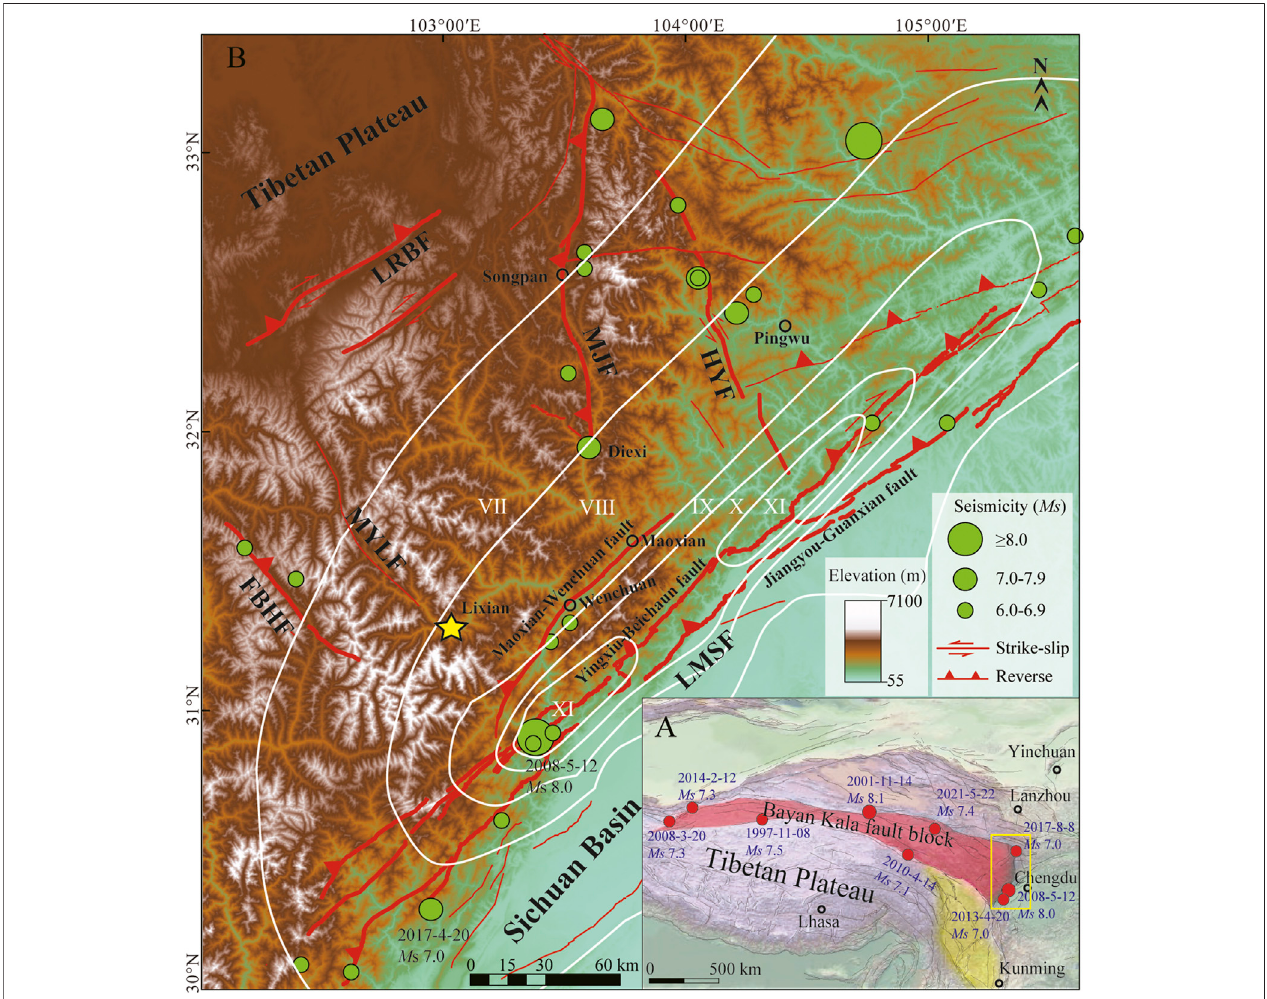
FIGURE 1 | Tectonic setting of the eastern margin of Tibetan Plateau (A) Epicenters distribution for M s ≥ 7.0 earthquakes in the Bayan Kala fault block since 1995 (Deng et al., 2014). Yellow box shows the extent of the B diagram (B) Major active faults (Xu et al., 2009) and the seismicity of the eastern margin of Tibetan Plateau. Seismicity data are from the China Earthquake Data Center (http://data.earthquake.cn/data). White line represents seismic intensity of Wenchuan earthquake. LMSF, Longmen Shan fault; LRBF, Longriba fault; HYF, Huya fault; MJF, Minjiang fault; MYLF, Miyaluo fault; FBHF, Fubianhe fault. The yellow star represents the Lixian